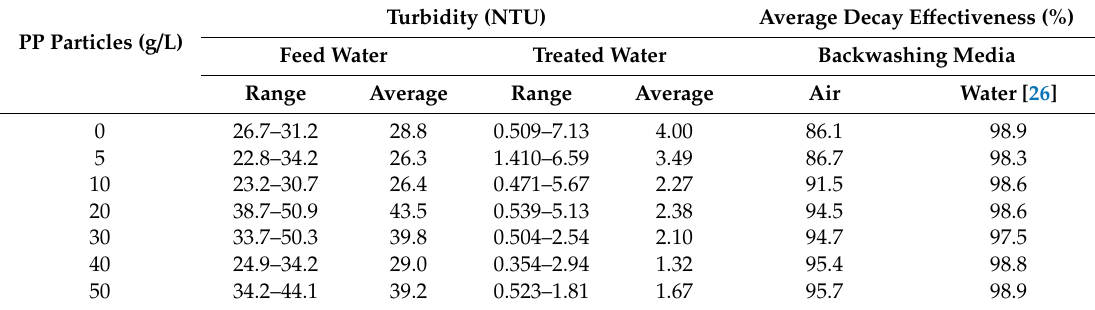
Table 10. Decay e ff ectiveness of turbidity for influence of the PP particles concentration in the integrated system, of multichannel ceramic MF and PP particles, using air backwashing; paralleled with the consequences of water backwashing.